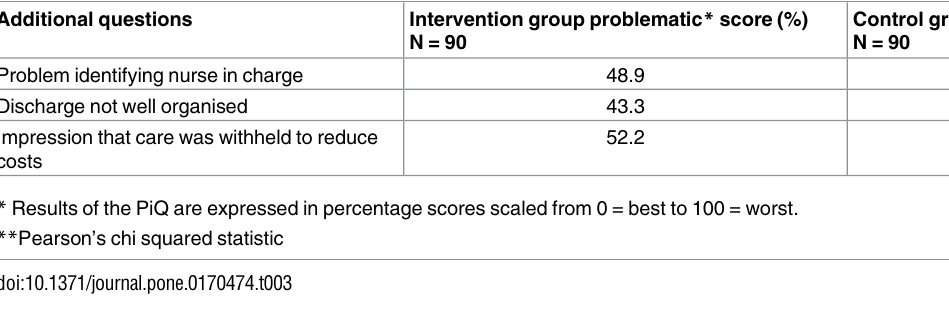
Table 3. Between group differences of problematic scores as measuredby additional